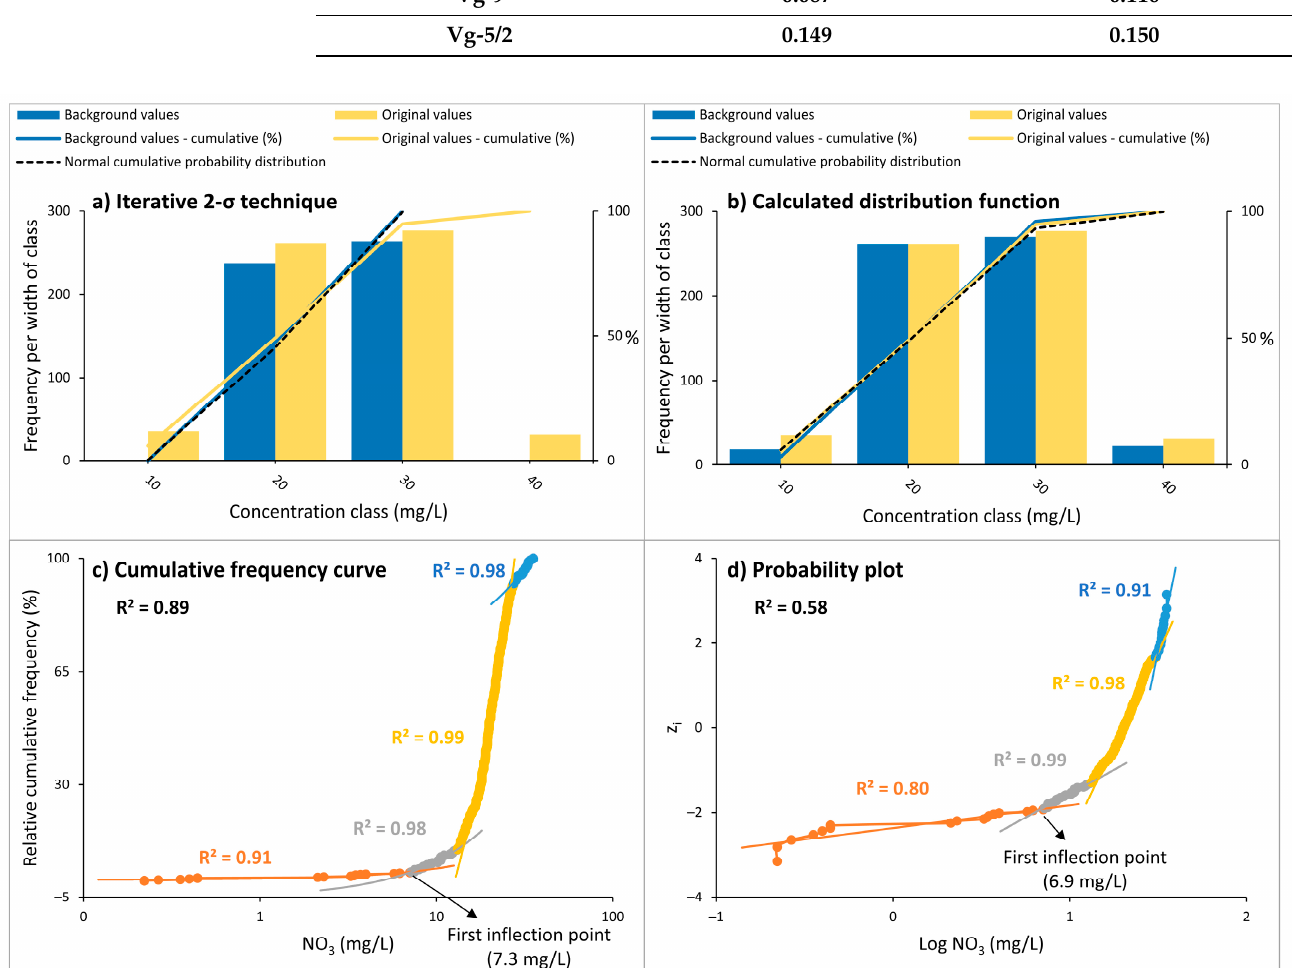
Figure 5. Four different methods to estimate ABV of nitrate for selected NON-ND data: ( a ) IT: lower background value: 13.2; D < D crit , ( b ) CDF: lower background value: 7.2; D < D crit , ( c ) CFC: background value: 7.3 and ( d ) PP: background value: 6.9. Arrow indicates first inflection point that separates background and non-background